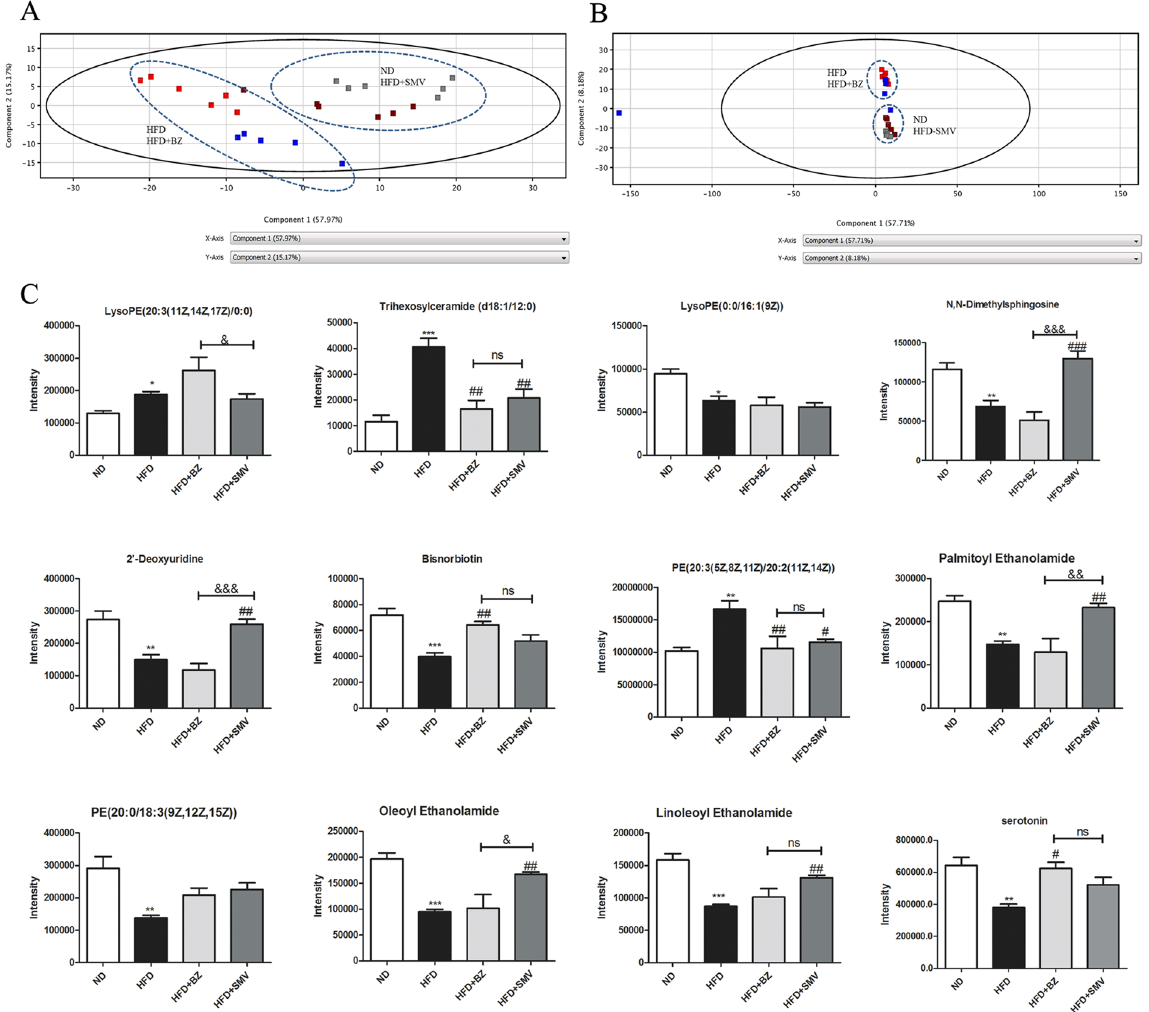
Figure 5. The effect of high fat diet and drug intervention (BZ & SMV) on the serum profiling in mice. The score plot of PCA analysis for serum samples from [HFD ( ▪ ), ND ( ▪ ), HFD + BZ ( ▪ ), HFD + SMV ( ▪ )] groups in ESI positive mode ( A ) and negative mode ( B ). Emotional-related differential compounds ( C ). * P < 0.05; ** P < 0.01; *** P < 0.001 vs. control group. # P < 0.05; ## P < 0.05 ; ### P < 0.001 vs. HFD group. & P < 0.05, && P < 0.01 between BZ group and SMV